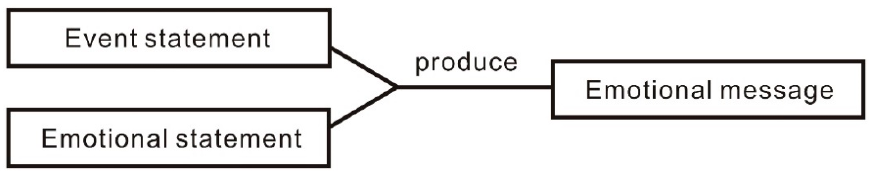
Figure 8. Schematic of the system message generation method.